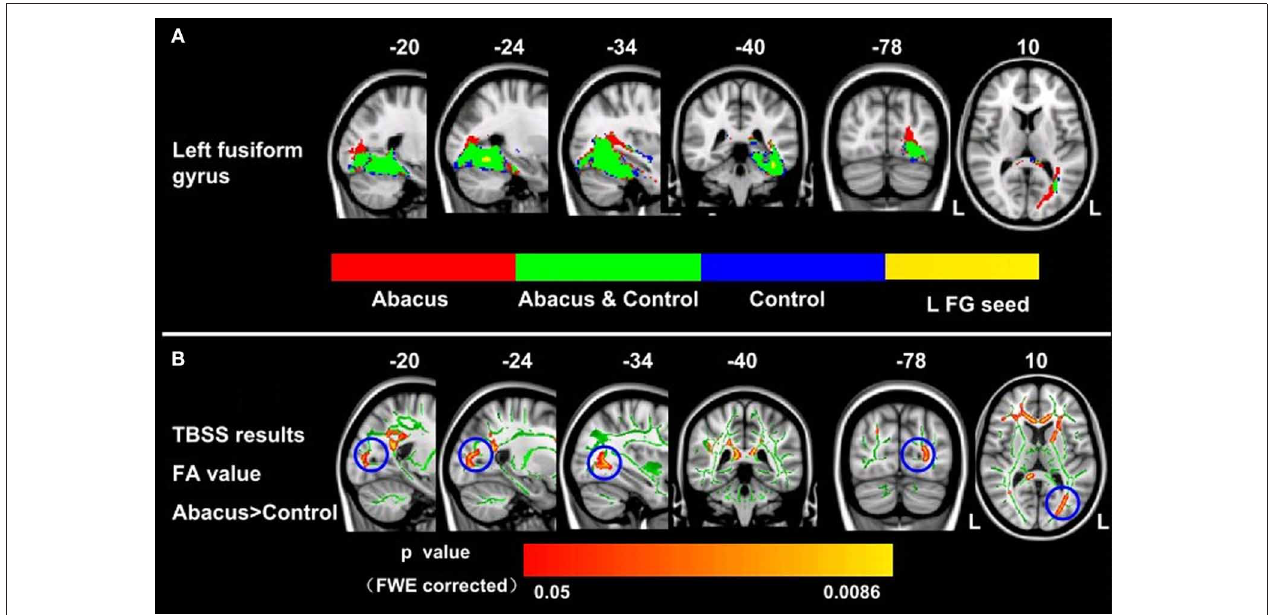
FIGURE 2 | Group probabilistic tractography pathways connecting left FG for each group. (A) Average fiber tracts connecting the left FG in abacus-trained group (red) and control group (blue). The probability maps overlapped onto a T1-weighted image (axial, coronal, and sagittal). The green areas indicate the overlap fiber tracts pathways of both groups. L, left. (B) White matter structures showed significant enhancement of FA in